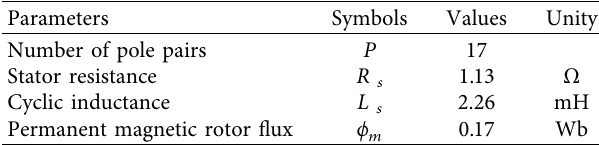
Table 2: Wind generator parameters.